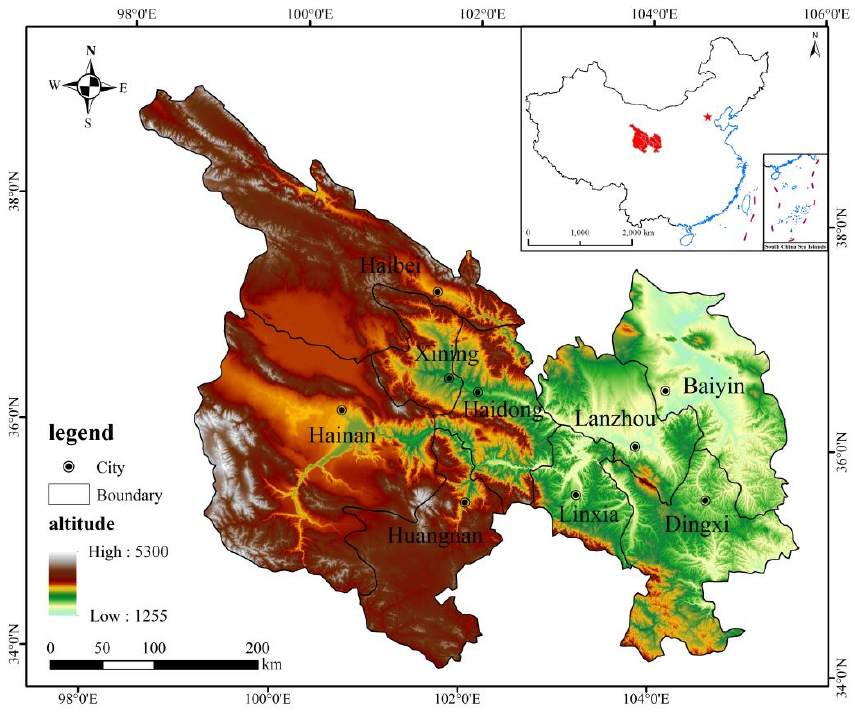
Figure 3. Study area. Note: This map is based on the standard map of the National Administration of Surveying, Mapping and Geographic Information, and the base map is not modified.